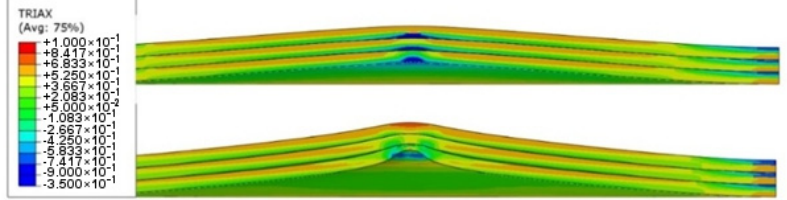
Figure 29. Stress triaxiality visualization in section view during the puncture of three titanium alloy sheets.